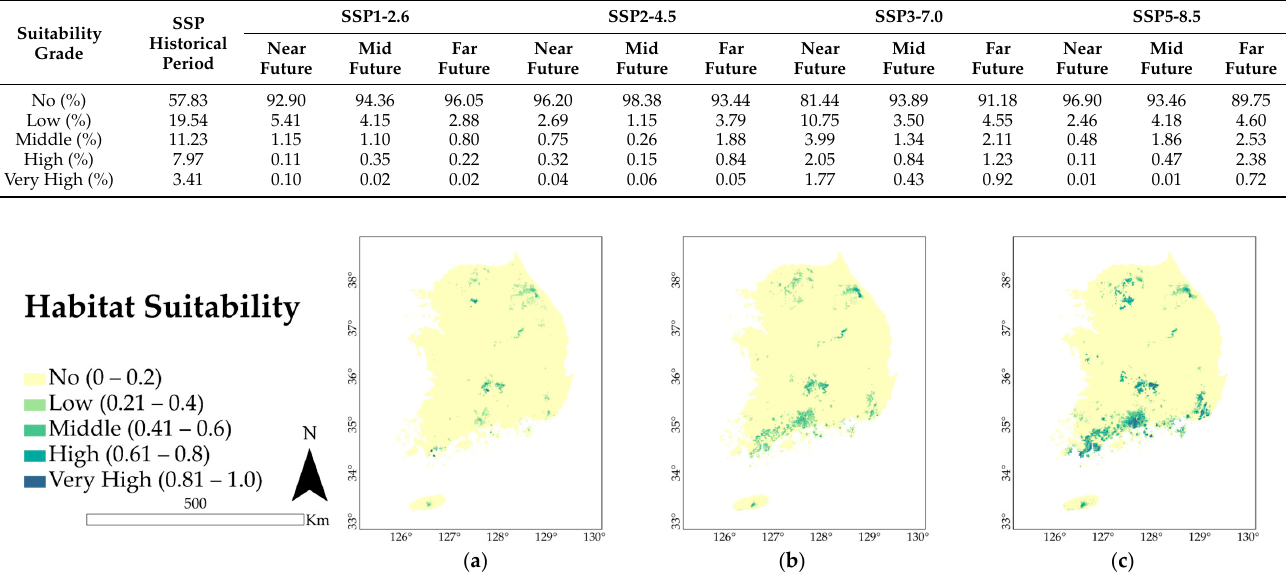
Figure 3. Predicted habitat suitability of A. pictum in South Korea under future condition: ( a ) SSP5-8.5 Near future; ( b ) SSP5-8.5 Middle future; ( c ) SSP5-8.5 Far future.